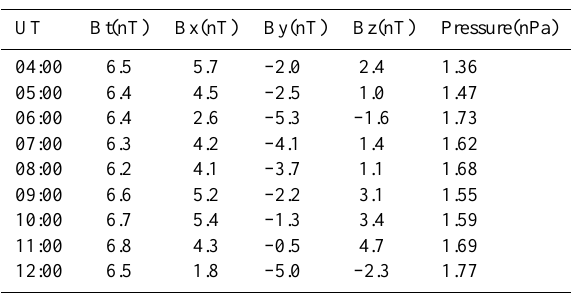
Table 1. The IMF (in GSE) and solar wind pressure on 3 March